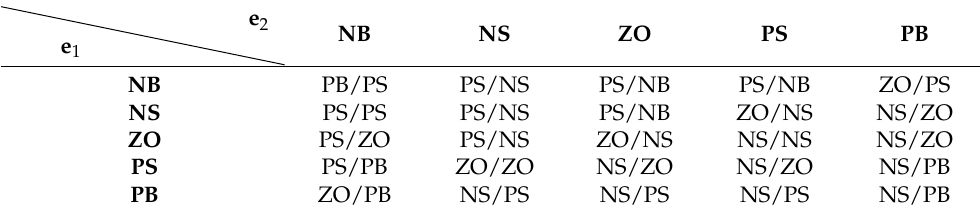
Table 7. Fuzzy rule table.